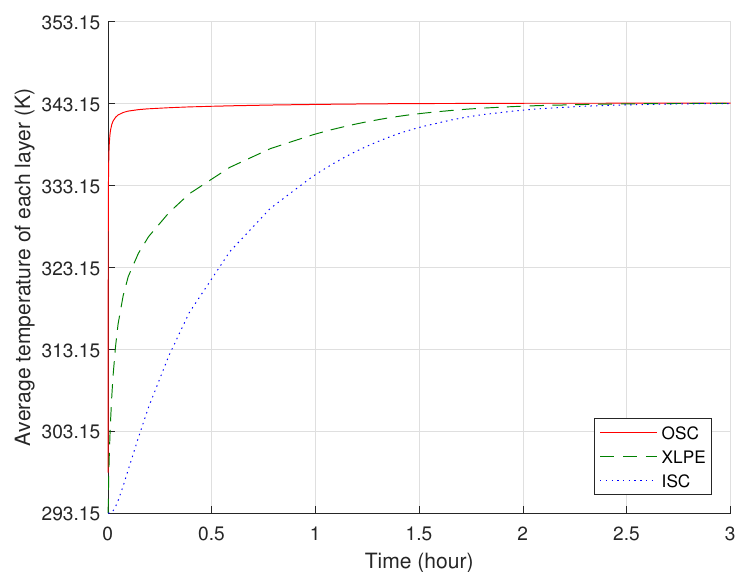
Figure 4. Average temperature variations of the OSC, XLPE, and ISC during the first three hours of degassing where the target degassing chamber temperature is 343.15 K.